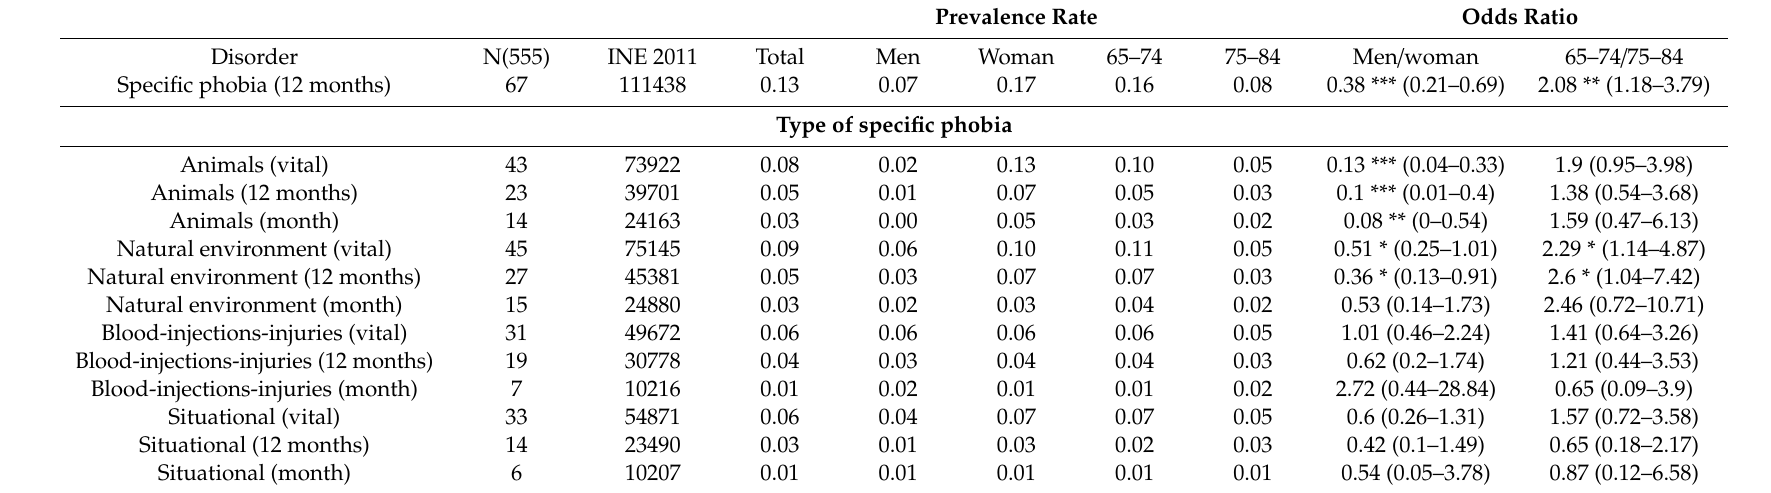
Table 2. Twelve-month prevalence rates of specific phobia disorder (gender and age di ff erences) and prevalence rates (vital, 12 months, and current) by type of specific phobia disorder (animals, natural environments, blood / injection / injury, and